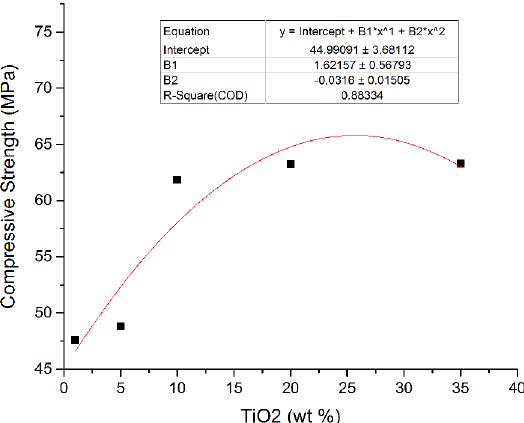
/ABS composites 2